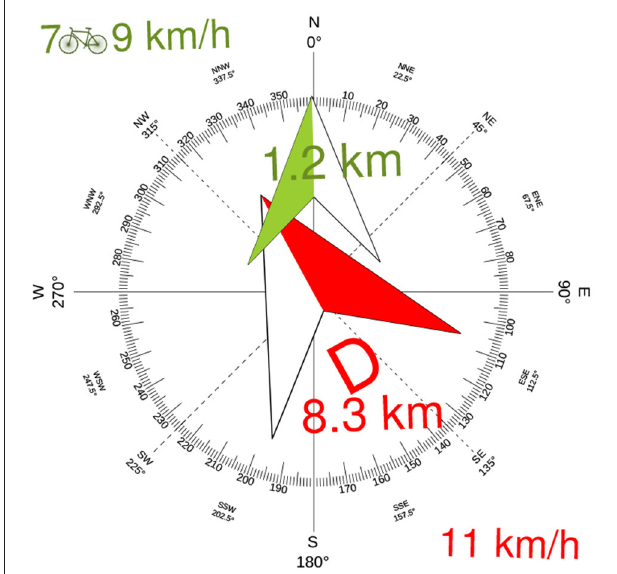
FIGURE 2 | Mock-up of the app running on mobile device. The arrows are properly oriented using the device’s magnetometer.